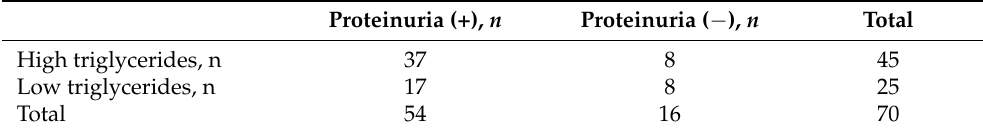
Table 6. The relationship between triglycerides and proteinuria in SLE-related kidney injury patients.